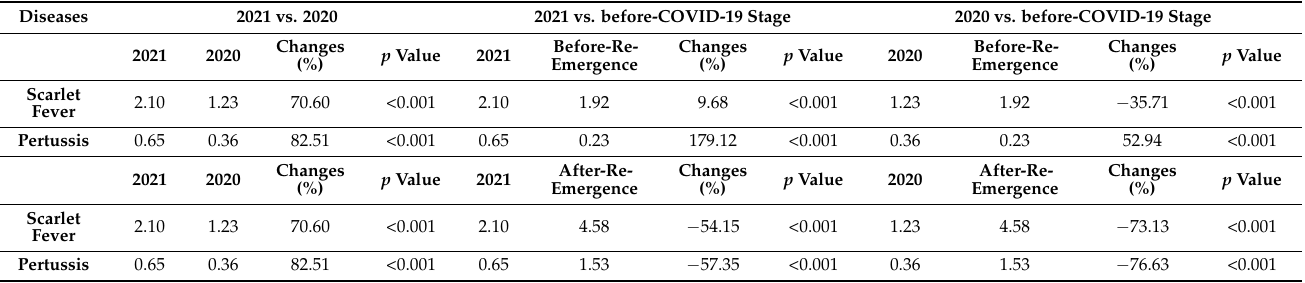
Table 1. Changes in the average yearly incidences (1/100,000) of scarlet fever and pertussis in 2020 and 2021 compared to previous years in Mainland China.